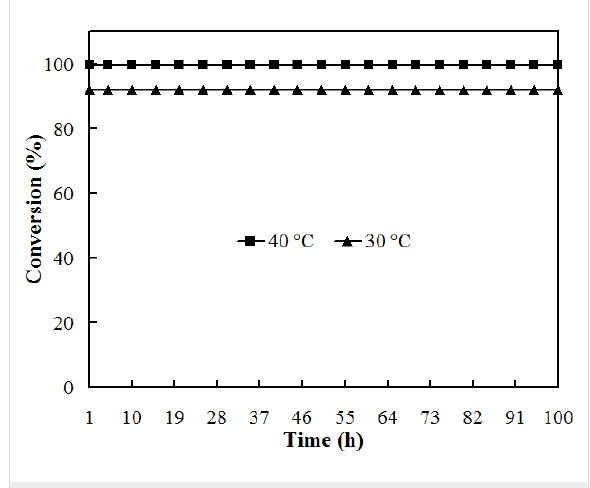
Figure 7: Long-term testing for continuous hydrogenation of 0.01 M p -nitrophenol with 0.05 M formic acid in the porous PdO-coated reactor. Residence time: 14.7